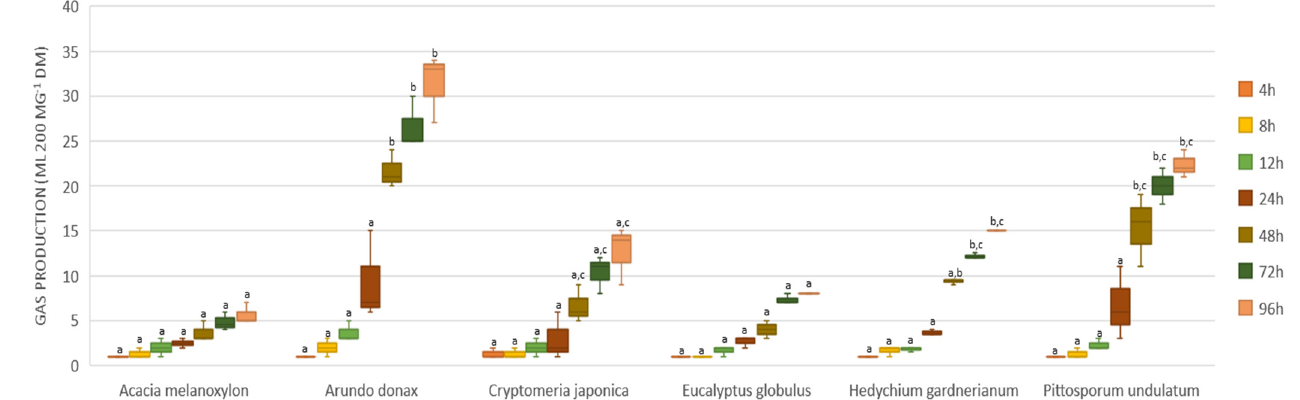
Figure 1. In vitro gas production during incubation of unconventional feeds in buffered rumen fluid at 96 h. Box-plot presentation showing the median, the middle 50% of the data (box), and gas volume ranges. Error bars represent maximum and minimum values per sample, while different letters indicate significant differences among the species, with the p -value significant at p ≤ 0.05. Table 3. Fitted values and parameters of kinetics in vitro gas production gas after 96 h incubation of the unconventional forages.